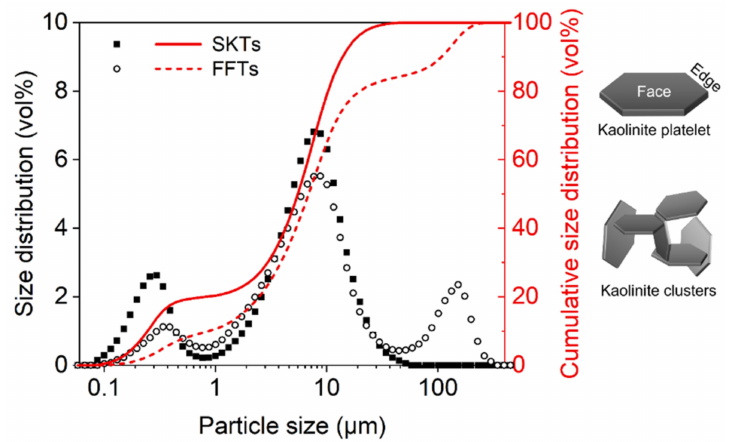
Figure 2. Particle Size distributions of synthetic kaolinite tailings (SKTs) and industrial fluid fine tailings (FFTs). The schematics at the right show the structures of kaolinite platelet and kaolinite clusters that potentially correspond to the 1st and 2nd peaks (starting from left) of SKTs,